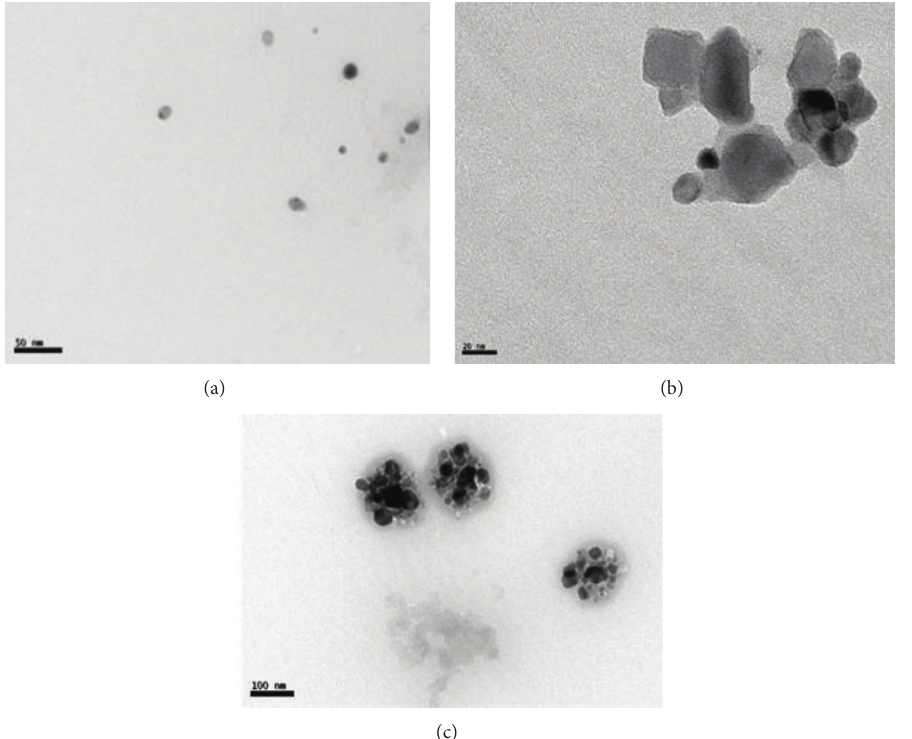
Figure 9: TEM images of (a) Au-Cu (1: 1), (b) Au-Cu (1:2), and (c) Au-Cu (1:3) alloy nanoparticles.